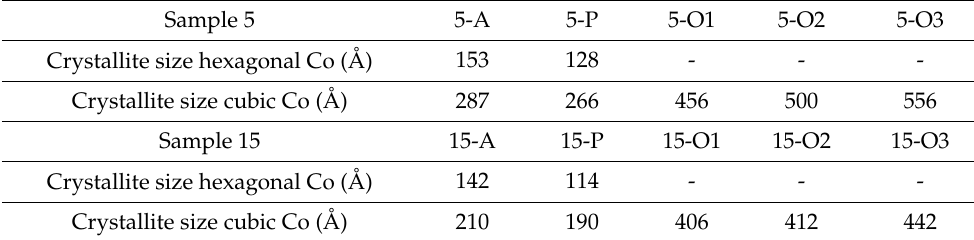
Table 7. Crystallite dimensions for the crystalline phases of